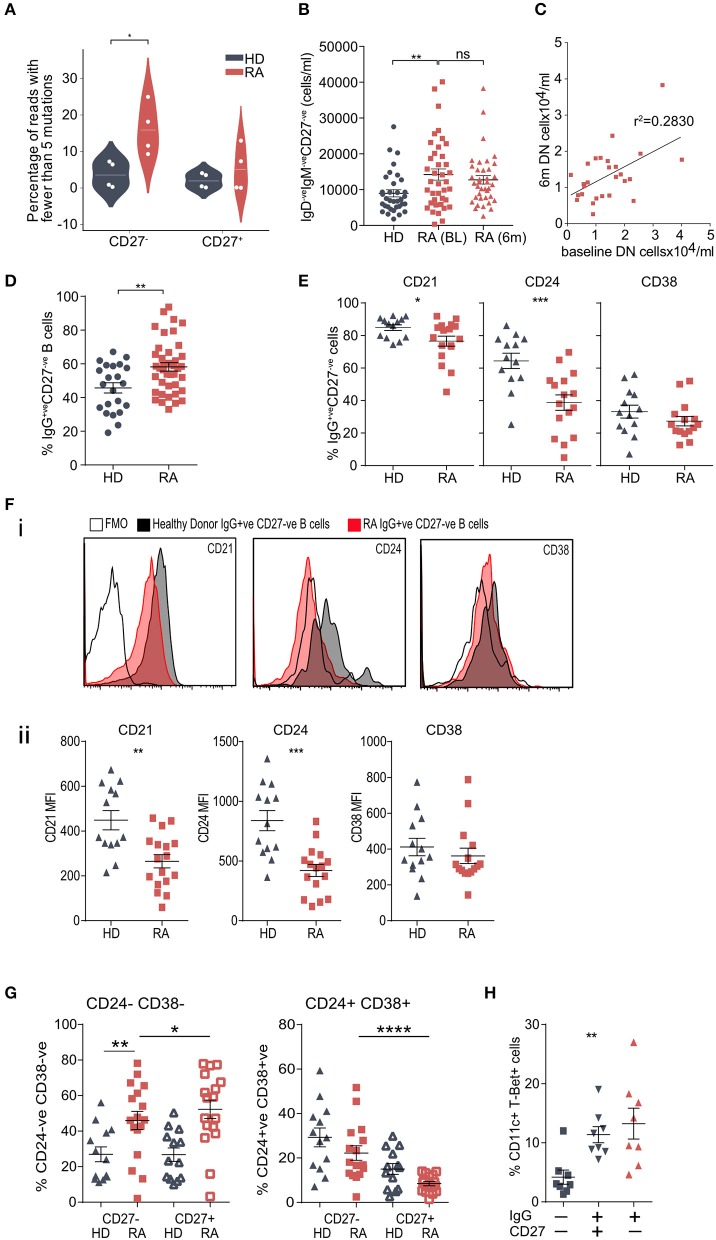
(A) Prevalence of hypomutated V segment sequences in CD27+ve and CD27−ve IgG+ve B-cells from RA and control donors. White spots indicate individual data points for each donor (n = 4 donors per group). P-value calculated using Mann-Whitney test. (B) Whole blood was stained for flow cytometry to determine cell number. IgD−veIgM−veCD27−ve B cells were gated and cells/ml calculated. n = 35 HD donors, n = 39 RA (0 m) donors, n = 38 RA (6 m) donors. P-value calculated using Mann-Whitney test. (C) Scatterplot of the frequencies of DN (IgD−veIgM−veCD27−ve) B cells from paired baseline and 6-month data from (B), to determine if the frequency of DN B cells was correlated in the same patient 6 months following DMARD therapy. n = 27 patients. R2 value calculated using Pearson's correlation. (D) Cell frequencies of CD20+veCD19+veIgG+veCD27−ve B cells from PBMCs from control donors and RA patients assessed by flow cytometry. Cells were gated for CD20+veCD19+veIgG+ve B cells then the proportion of CD27−ve cells determined. n = 22 HD donors and 42 RA donors. P-value calculated using unpaired T-test. (E) Cell surface markers of IgG+veCD27−ve B cell population were analyzed by flow cytometry. Gating strategy is detailed in Supplementary Figure 8. n = 13 HD donors and 16 RA donors. P-values calculated using Mann-Whitney test. Further surface markers are shown in Supplementary Figure 8. (F) (i) Representative histogram plots of relevant fluorescence minus one (FMO) shown with open black line, healthy donor IgG+veCD27−ve (shaded black line) and RA IgG+veCD27−ve (shaded red line). (ii) Mean Fluorescence Intensity (MFI) data for individual samples was plotted for HD (gray) and RA (red) IgG+ve CD27−ve B cells. P-values were calculated using the Mann-Whitney test. n = 13 HD donors and 16 RA donors. (G) IgG+veCD27−ve B cells were also analyzed for dual staining of CD24 and CD38 by flow cytometry. Percentage was plotted for HD (gray) and RA (red) for both IgG+veCD27−ve (filled symbol) and IgG+veCD27+ve (open symbol) populations. For comparison of HD and RA IgG+ve CD27−ve populations P-values were obtained using Mann-Whitney test. For comparison of RA IgG+veCD27−ve to RA IgG+ve CD27+ve populations, P-values were obtained using Wilcoxon paired test. (H) Percentage of CD20+veCD19+ve CD11c+ T-Bet+ve B cells within RA PBMC IgG−veCD27−ve, IgG+veCD27+ve and IgG+veCD27−ve B cells. IgG+ve B cell populations had a higher percentage of CD11c+ T-Bet+ve B cells than IgG−veCD27−ve, but there was no significant difference in the percentages of CD11c+ T-Bet+ve B cells within IgG+ve B cells. n = 8 RA donors. P-value calculated using Wilcoxon matched-pair test. *p < 0.05, **p < 0.01, ***p < 0.001, ****p < 0.0001.